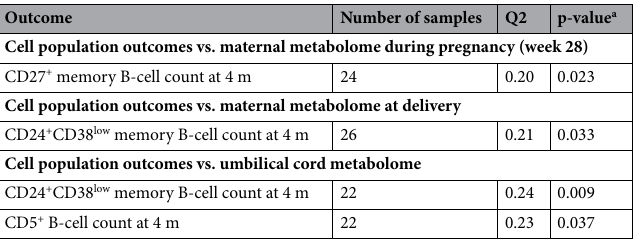
Table 2. Associations of T- and B-cell phenotypes with the plasma metabolomes from the mothers (at third trimester and at delivery) and infants (umbilical cord). a p-value from permutation test (n = 100).